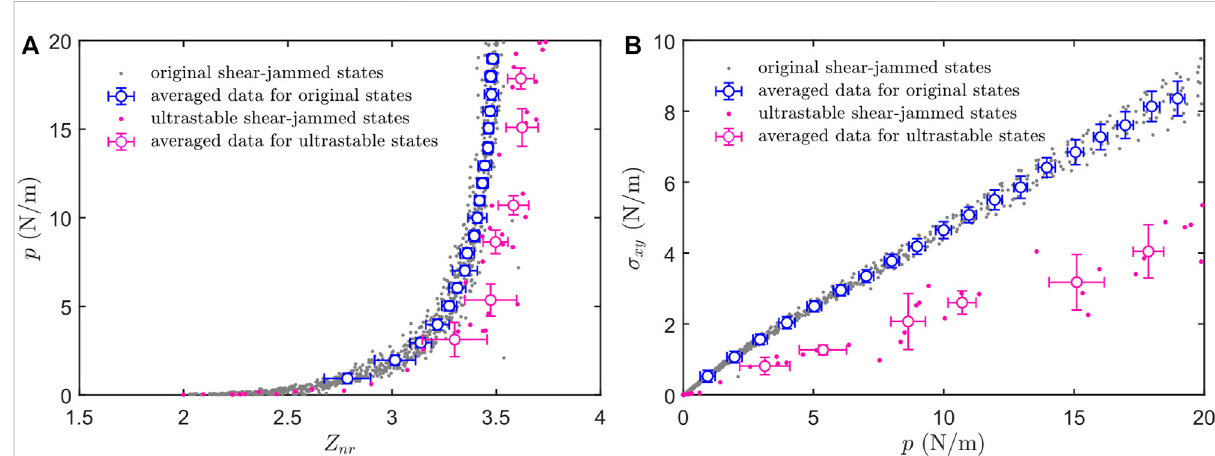
FIGURE 7 Groupultrastable statesand original statesinto ensemblesaccordingto their stressstates. (A) The pressure oftheoriginalshear-jammedstates formedbyinitialshearalone(graydots)andoftheultrastablestates(purpledots)plotted versus thenon-rattlercontactnumber.Theaveragedvalues forstatesusedincalculatingstresscorrelationsarealsoplotted. (B) Theshearstressoftheoriginalshear-jammedstatesformedbyinitialshearalone (gray dots) and of the ultrastable states (purple dots) plotted versus pressure. The averaged values for states used in calculating stress correlations are also